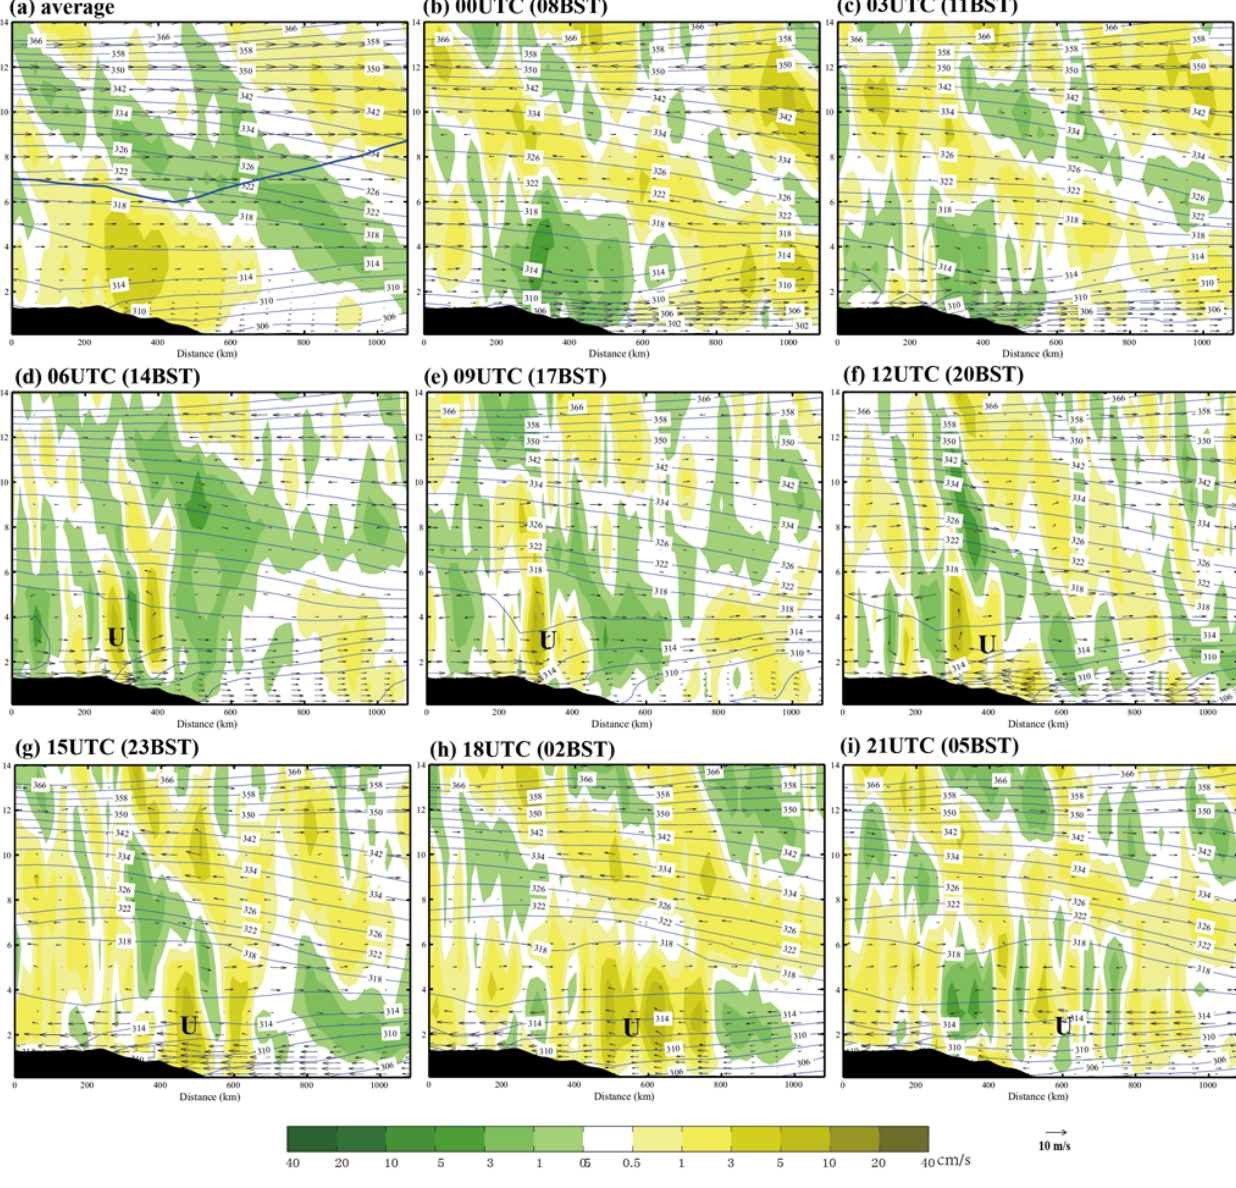
Fig. 10. As in Fig. 8, but for Fake-dry